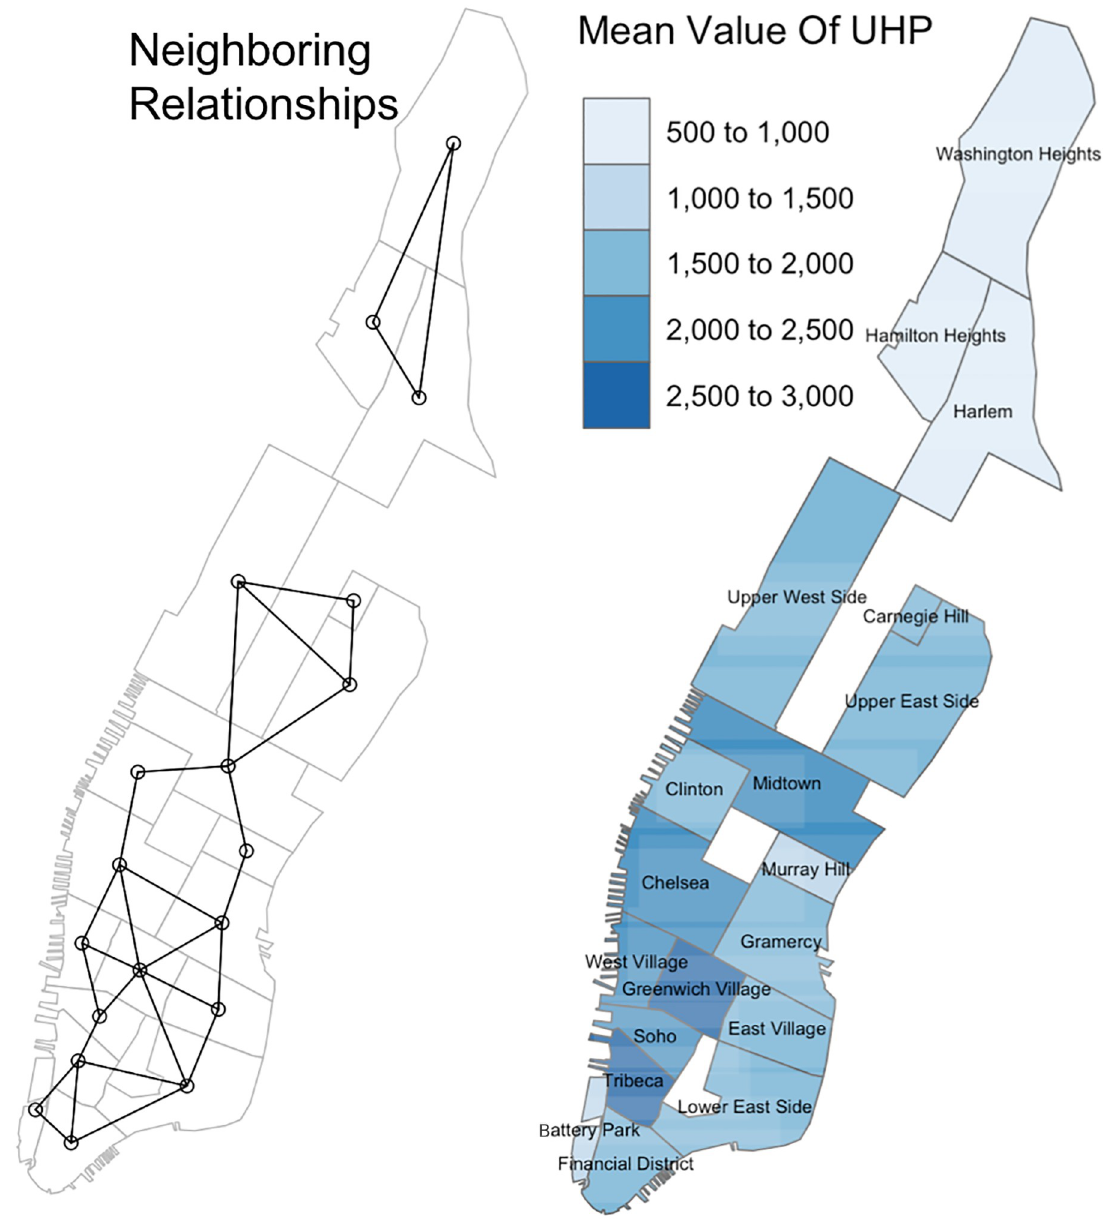
Fig 8. Relationships and mean values: (left) adjacency relationship map of neighborhoods (dots represent neighborhoods, edges indicate adjacent neighborhoods), (right) mean values of average unit house price (UHP).